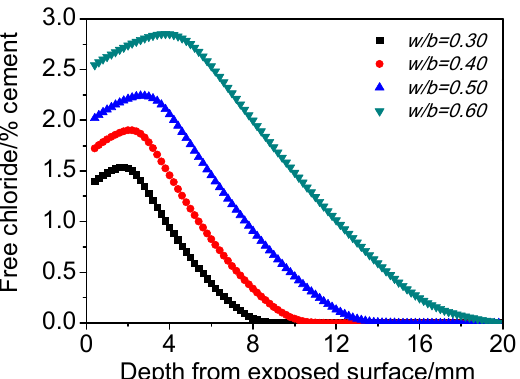
Figure 10. Influence of w / b on chloride distribution of concrete subjected to cyclic wetting and drying conditions.